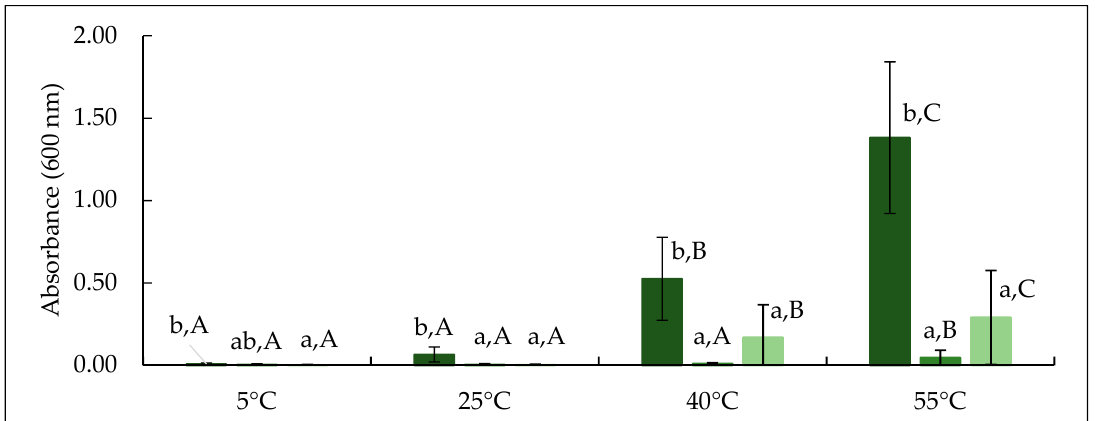
Figure 6. Absorbance at 600 nm of CTR, TA and TB permeate samples incubated at 5, 25, 40 and 55 °C. CTR: no enzyme treatment ( ■) ; TA: 5 °C/24 h ( ■) ; TB: 40 °C/90 min ( ■). Different lowercase letters indicate significant differences ( p < 0.05) between treatment. Different uppercase letters represent significant differences ( p < 0.05) between incubation temperature.